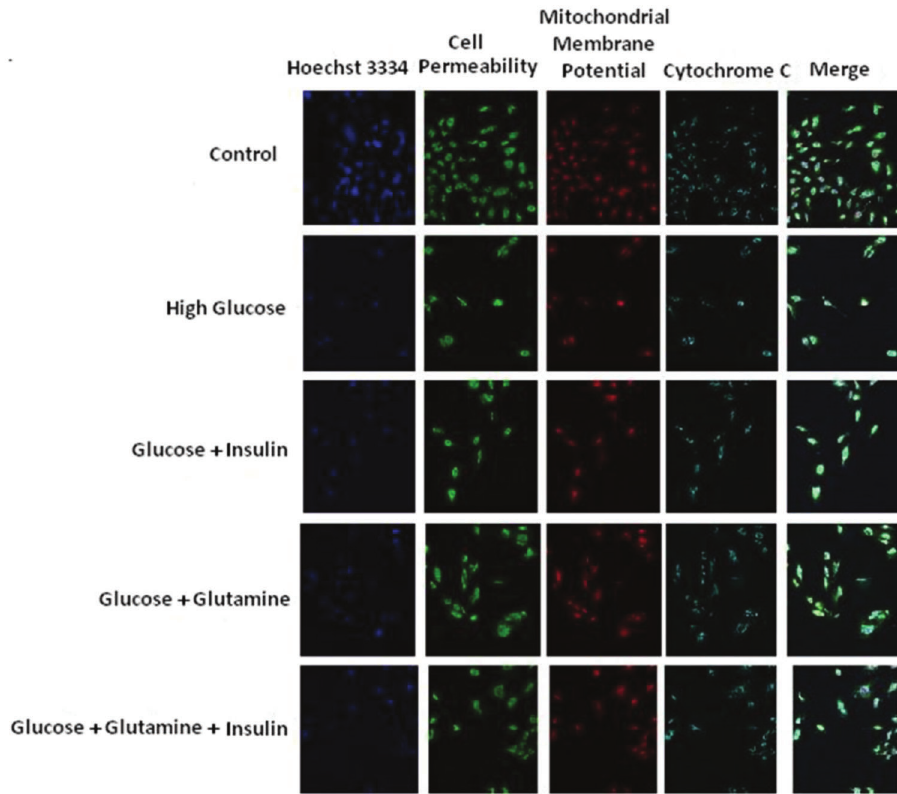
Figure 1 - Representative images of endothelial cells treated with medium alone (control), glucose alone (20mM), glucose (20mM) + insulin (10 -6 M), glucose (20mm) + glutamine (40mM) and glucose (20mM) + glutamine (40mM) + insulin (10 -6 M). Cells were stained with Hoechst for nuclear, cell permeability dye, mitochondrial membrane potential dye and cytochrome c. The image from each row was obtained from the same field of the same treatment sample (magnification 20